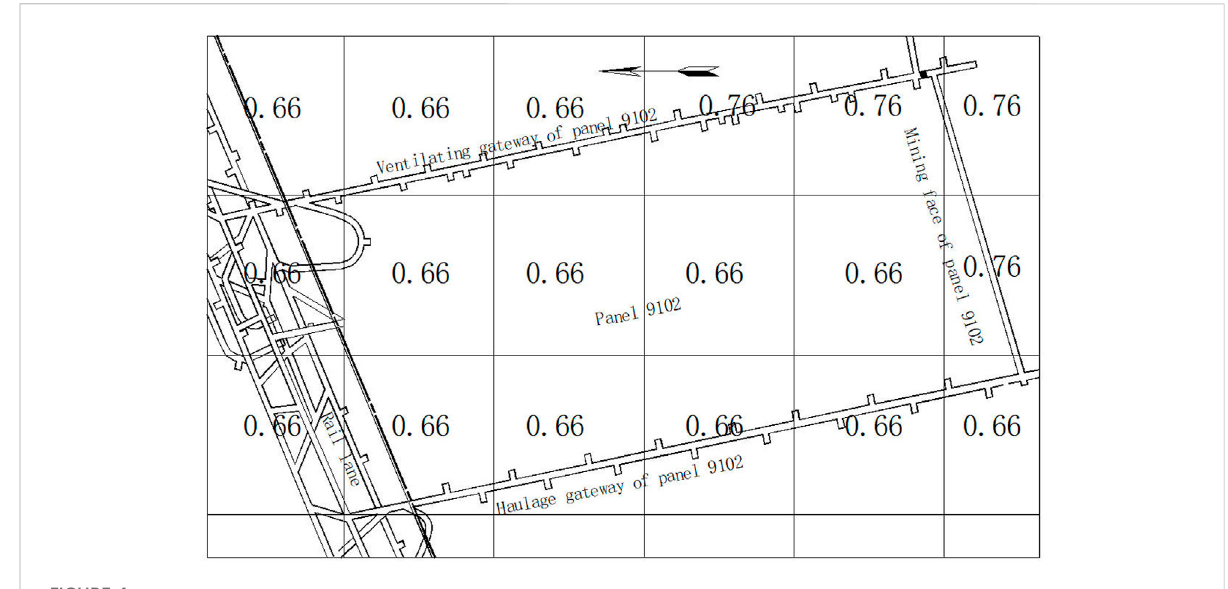
FIGURE 4 Prediction results of multi-factor pattern recognition for rockburst hazard in panel